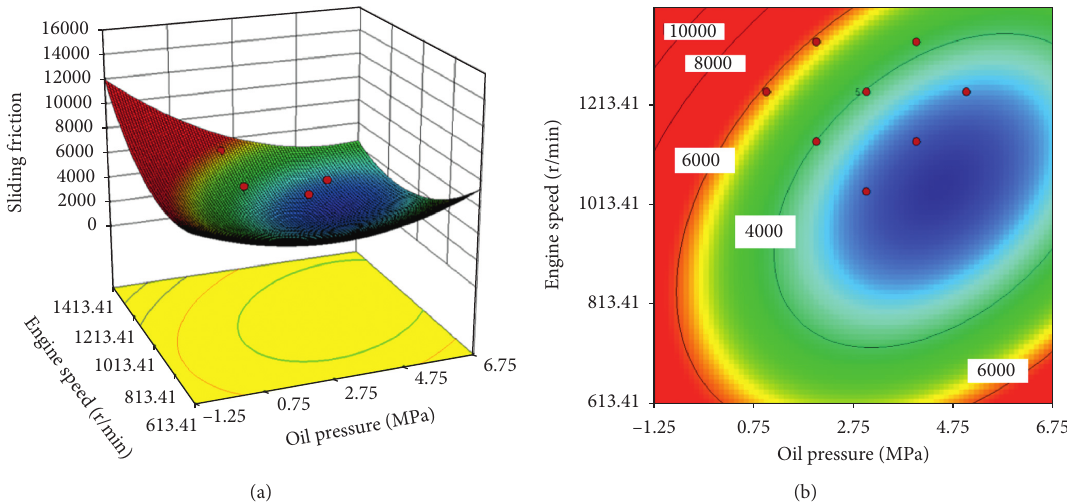
Figure 7: Response surface diagram and contour map of oil pressure and engine speed on interaction of sliding